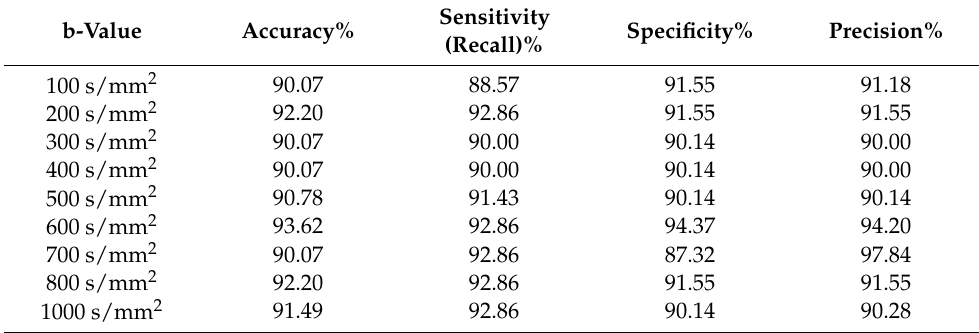
Table 6. Performance of VGGNet at 9 b-values using 141 randomly chosen ADC maps.